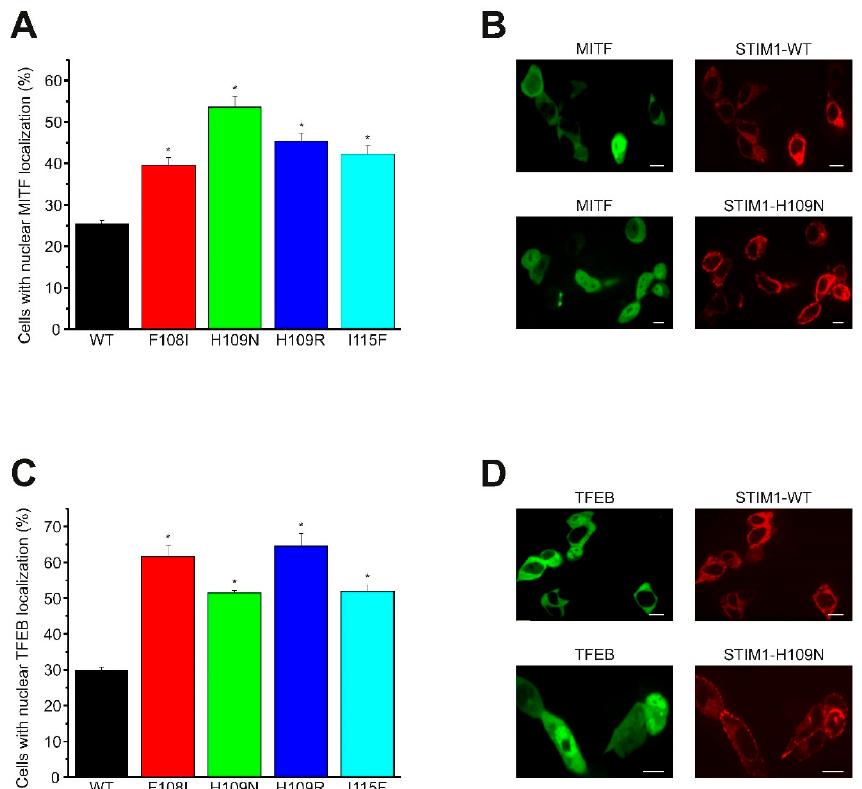
Figure 4. Nuclear trans-localization of microphthalmia-associated transcription factor (MITF)/TFE transcription factor family induced by heterologous expression of non-canonical EF-hand mutants. ( A , C ) Statistical analysis provided the percentages of cells with nuclear localization of ( A ) CFP-tagged MITF or ( C ) CFP-tagged transcription factor EB (TFEB) upon co-expression with STIM1 wild type, STIM1-F108I, STIM1-H109N, STIM1-H109R, and STIM1-I115F, respectively. For each construct, n = 173 to 323 cells were measured on three different days. An asterisk (*) indicates a significantly increased number of cells with nuclear MITF or TFEB localization compared to wild type STIM1 co-expression ( t -test: p < 0.01). ( B , D ) Representative example images of cells co-expressing ( B ) CFP-tagged MITF or ( D ) CFP-tagged TFEB and YFP-tagged STIM1 wild type, and STIM1-H109N, respectively. Scale bar 10 µ